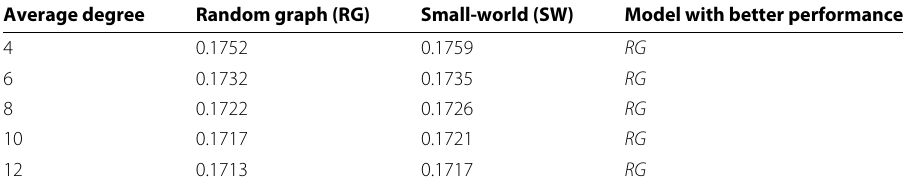
Table 3 Performance comparison of Energy Cost between the small-world and the random graph Average degree